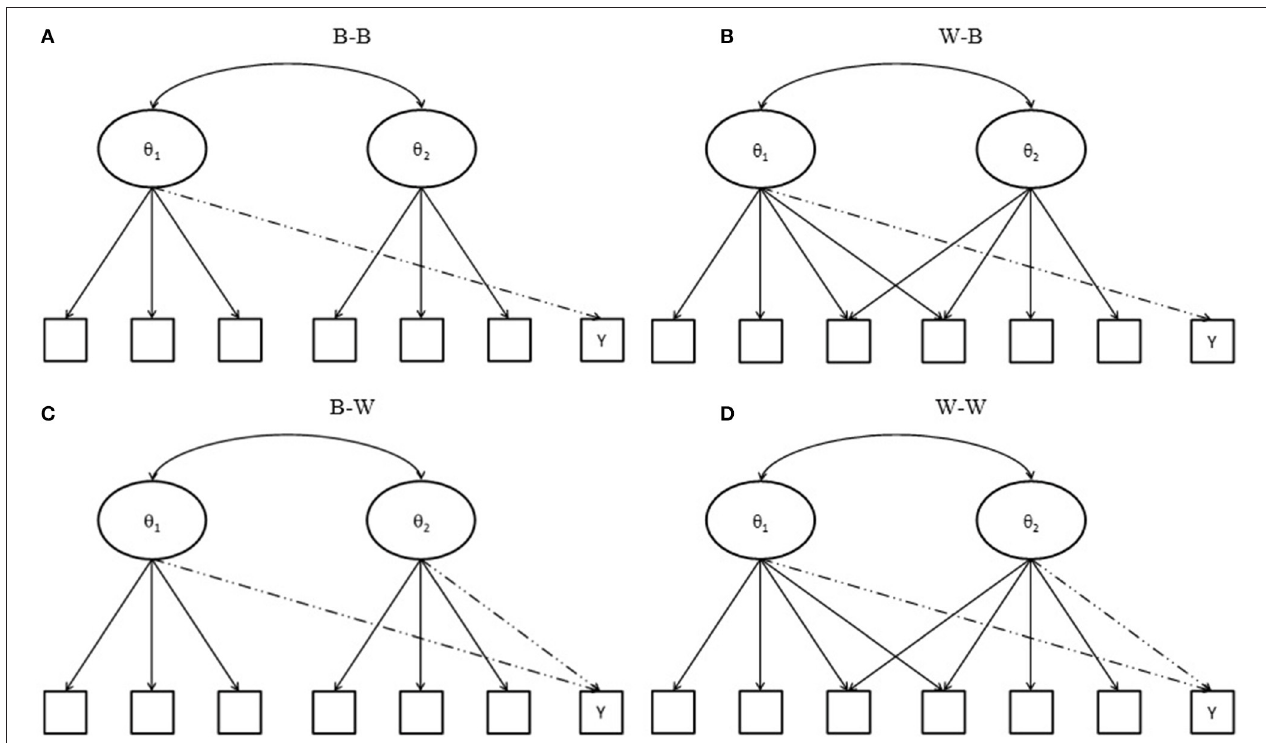
FIGURE 1 | Test structure of a matching variable and an item under consideration. Y indicates an item under consideration; (A) B-B indicates between-item multidimensionality of a matching variable with a between-item multidimensional item under consideration; (B) W-B indicates within-item multidimensionality of a matching variable with a between-item multidimensional item under consideration; (C) B-W indicates between-item multidimensionality of a matching variable with a with-item multidimensional item under consideration; and (D) W-W indicates within-item multidimensionality of a matching variable with a within-item multidimensional item under